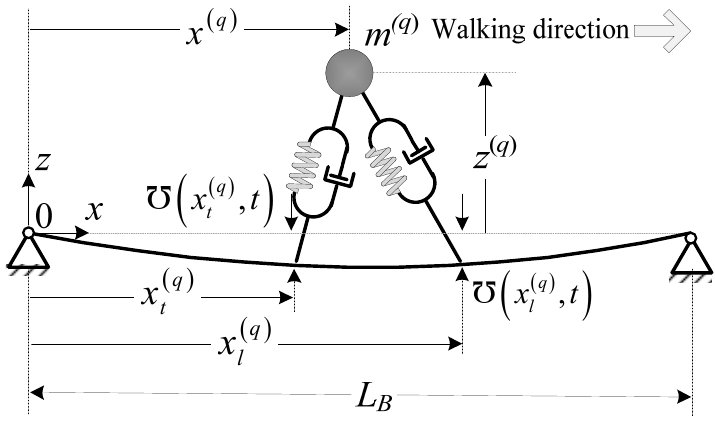
Figure 1. Crowd ‐ structure interaction model. Figure 1. Crowd-structure interaction